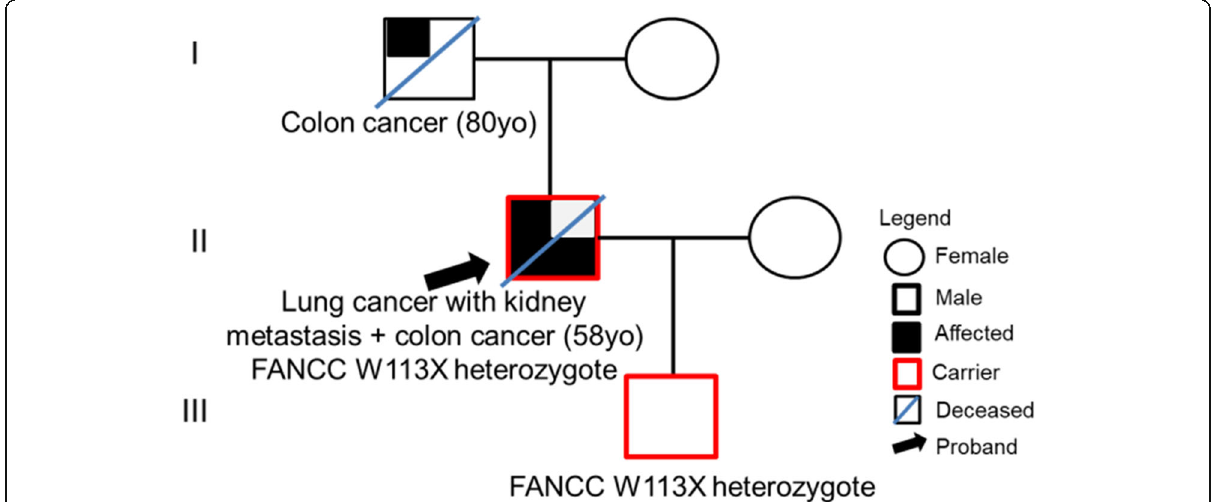
Fig. 3 Pedigree analysis illustrating the family history of colon cancer and the detection of FANCC W113X in the patient (II) and his son